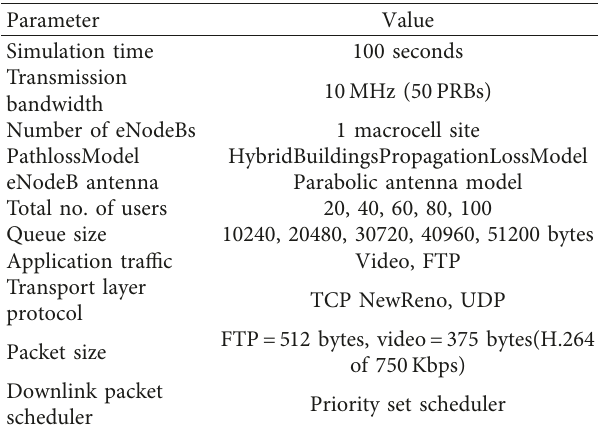
Figure 2: 4G network coverage area. Table 1: Configuration parameters used in simulation